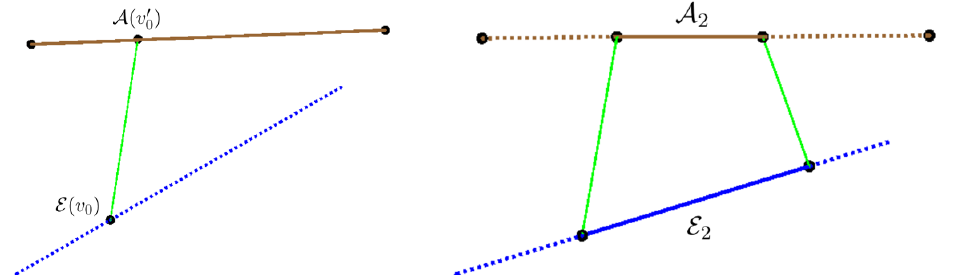
Figure 8 . The right (cid:12)gure shows the correspondence between the point A ( v 0 E ( v 0 ) on E with v 0 and v 0 satisfying (5.18). Also they are the points where the modular plane P ( v 0 ) 0 intersect with A and E . The green line is R A ( v 0 ). The left (cid:12)gure shows, in the same sense, an arbitrary sub-interval A 2 corresponds to a subinterval E 2 on E